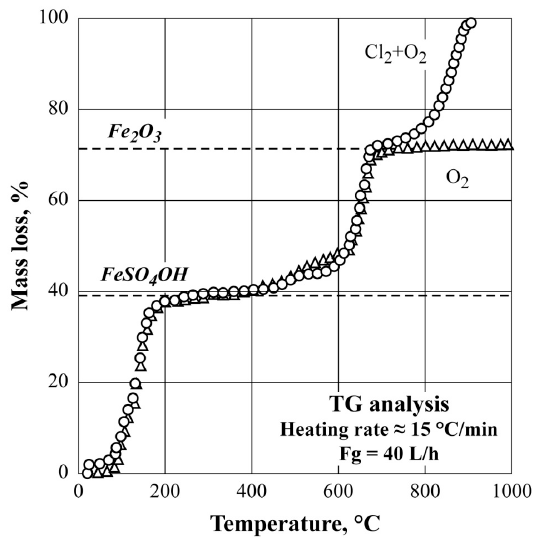
Figure 3. TG analysis of a FeSO 4 ∙ 7H 2 O sample in O 2 and Cl 2 + O 2 atmospheres. Table 2. Endothermic peaks ( ◦ C) revealed by differential thermal (DT) analysis for the treatment of FeSO 4 · 7H 2 O under nitrogen at various heating rates. Heating Rate, ◦ C/min Possible Reaction Steps